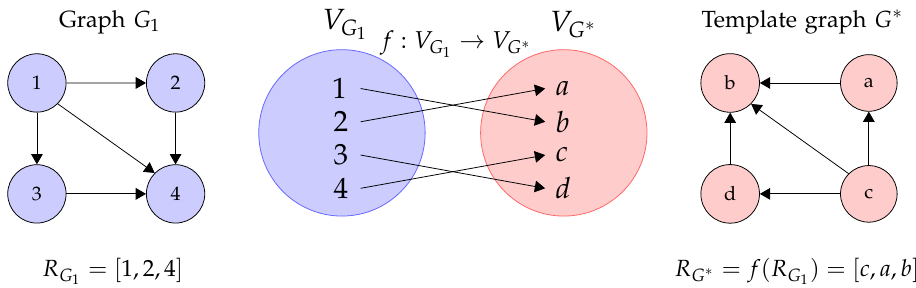
Figure 11. Graphical depiction of the route mapping. The graph G 1 is shown in purple. The graph Figure 11. Shown is a graphical depiction of the route mapping. With purple, the graph G 1 . With red, G ∗ is shown in the graph G ∗ .